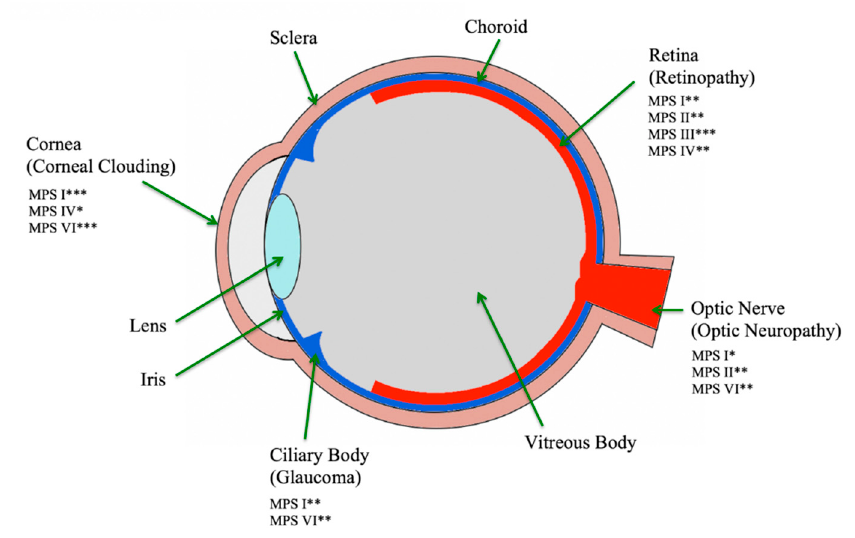
Figure 1. Sagittal view of eye listing area of effect in MPS (mucopolysaccharidosis) subtypes. Modified from [2,3]. * mild, ** moderate, ***